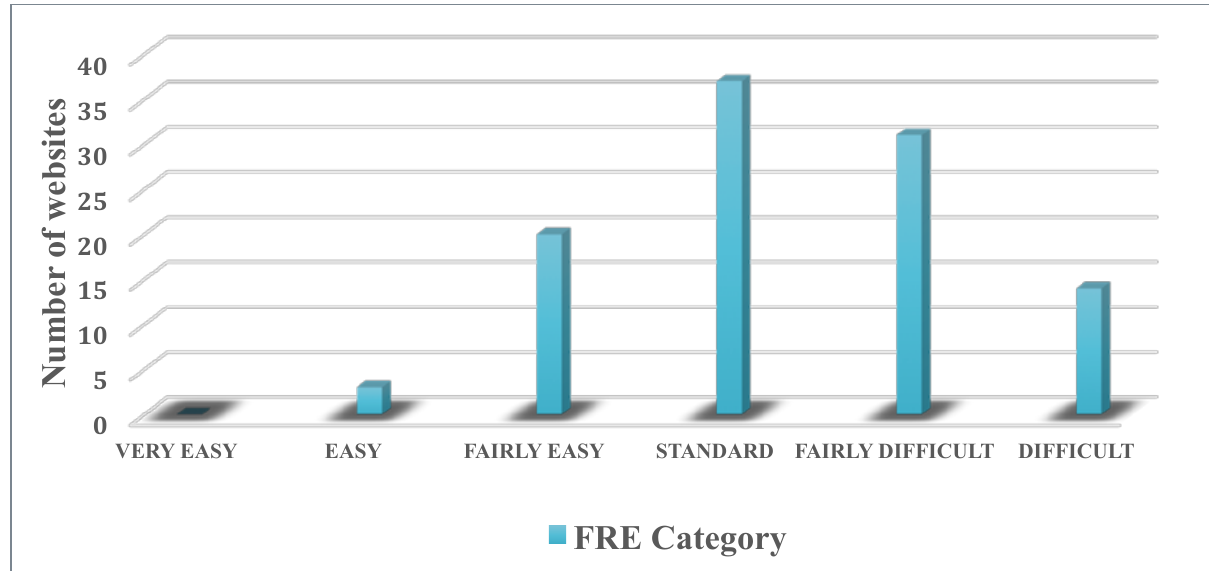
Table VI. Distribution of evaluated websites by FRE category (N =